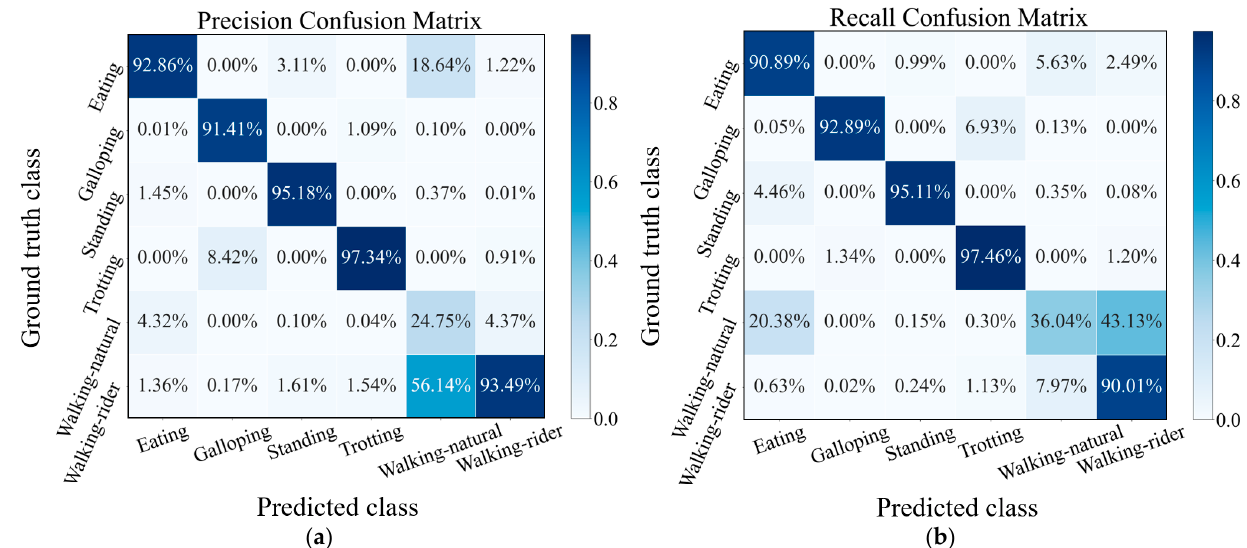
Figure 7. Precision ( a ) and recall ( b ) confusion matrix of CMI-Net with CB focal loss ( γ = 0.5).